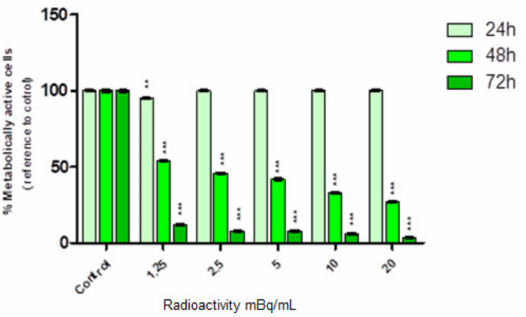
Figure 7. Cell viability after treatment with different radioactivity of SPION- 198 Au–PEG conjugates. HepG2 cells were incubated for 24, 48, and 72 h. The results are expressed as a percentage of control cells. Significant p ≤ 0.01 (**), p ≤ 0.001